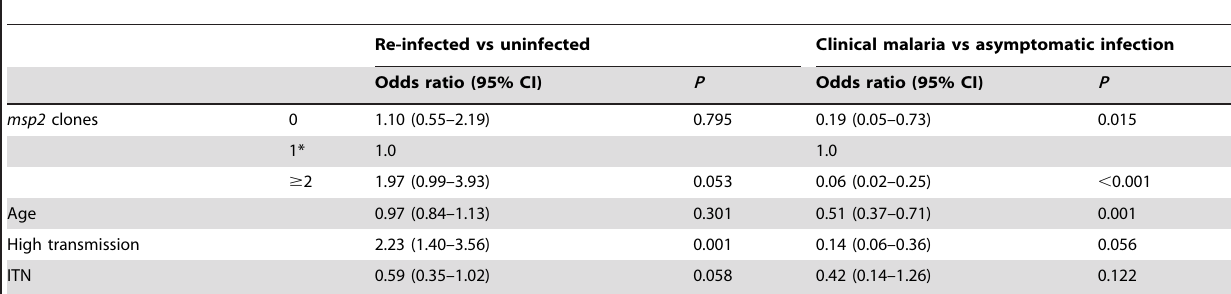
Table 3. Factors associated with re-infection, asymptomatic parasiteamia or clinical malaria during follow-up after anti-malarial